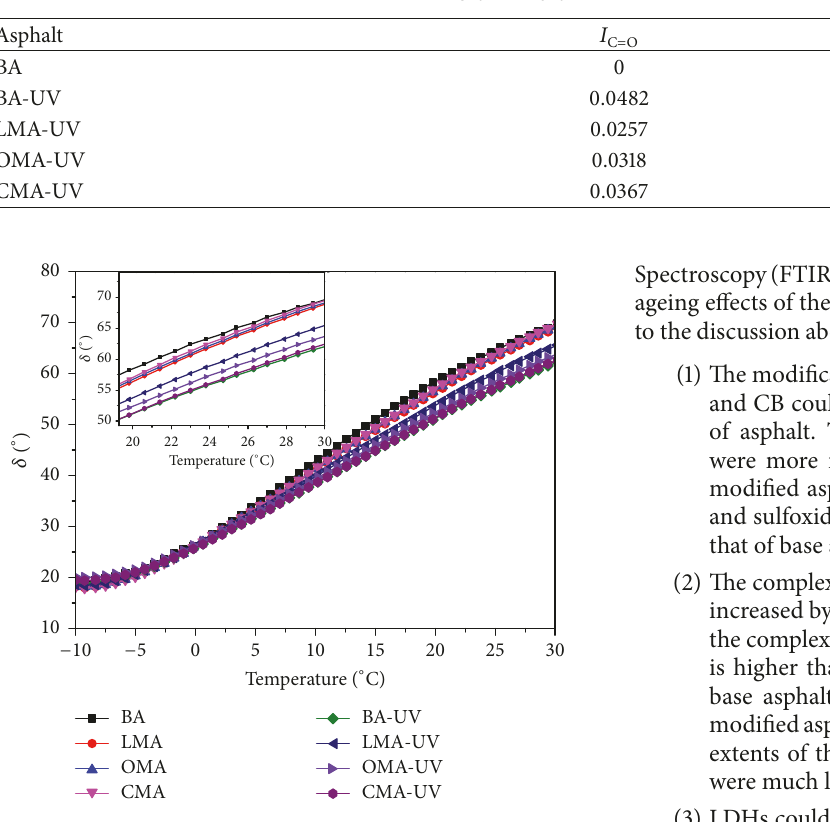
after ageing is slightly higher than base bitumen. It indicated that UV resistance of modified bitumen is increased. Varia- tion of 𝛿 of CB before and after UV ageing is slightly bigger than LMA, which means that the anti-UV ageing effects are better than